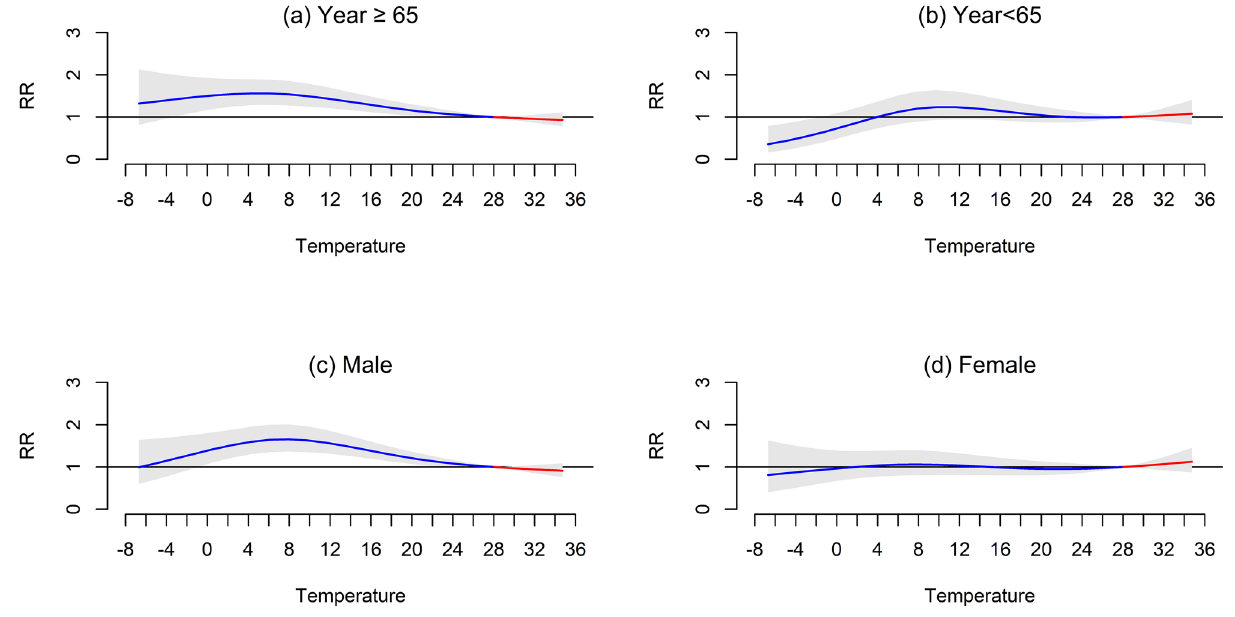
Figure 3. Stratified analysis temperature effects (mean temperature, lag 0–21 days) by total in-hospital death between age groups and gender,